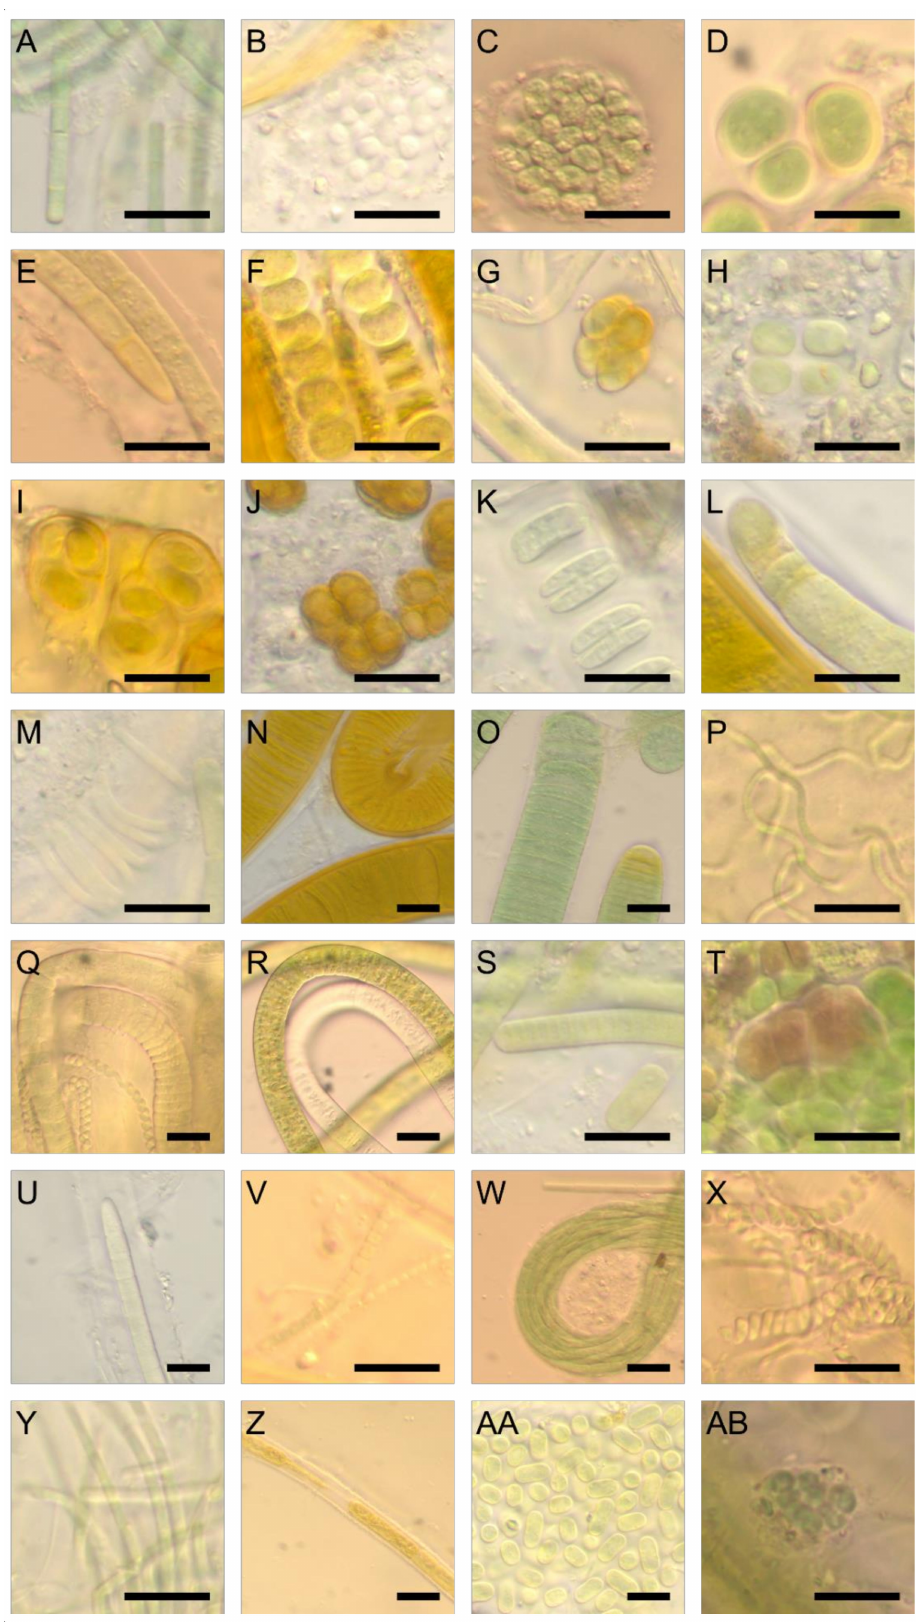
Figure 3. Representative morphologies of cyanobacterial taxa identified using light microscopy. ( A ) Anagnostidinema sp., a filamentous cyanobacterium with rounded end. ( B ) Aphanocapsa sp., a